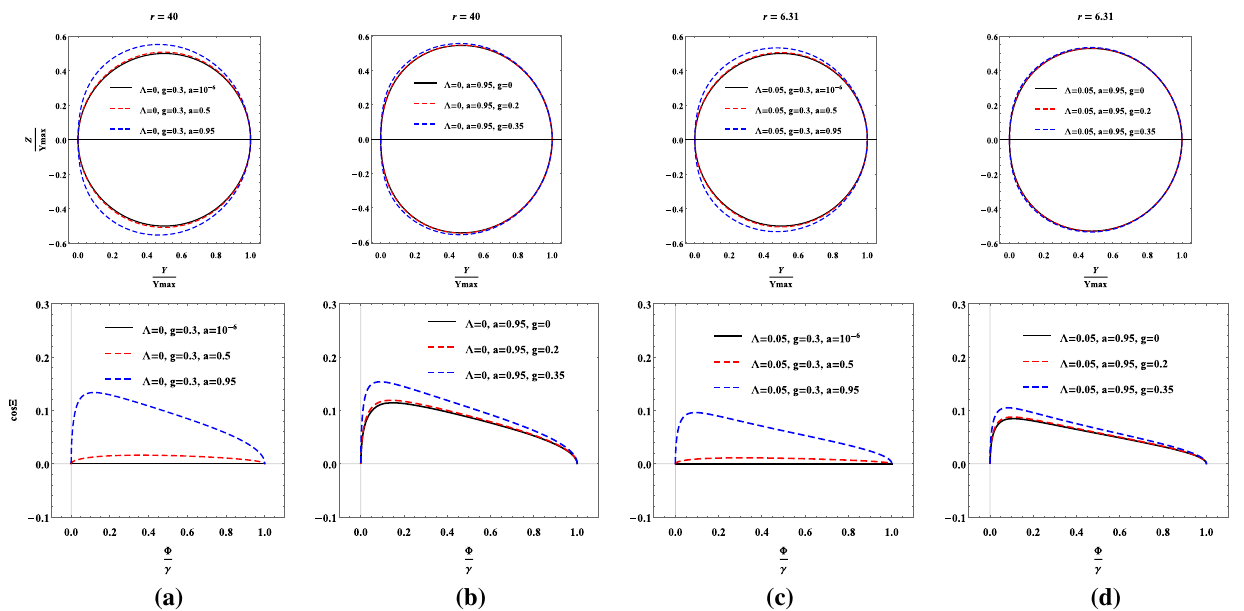
monopole charges for observers located at r = 40. c Shadows and distortion parameters of rotating Hayward–de black holes of selected different spin parameters for observers located at r = 6 . 31. d Shad- ows and distortion parameters of rotating Hayward–de black holes of selected different the magnetic monopole charges for observers located at r = 6 .